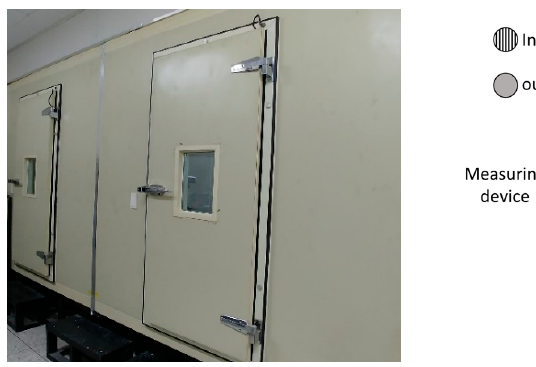
Table 1. Equipment used in the experiments.